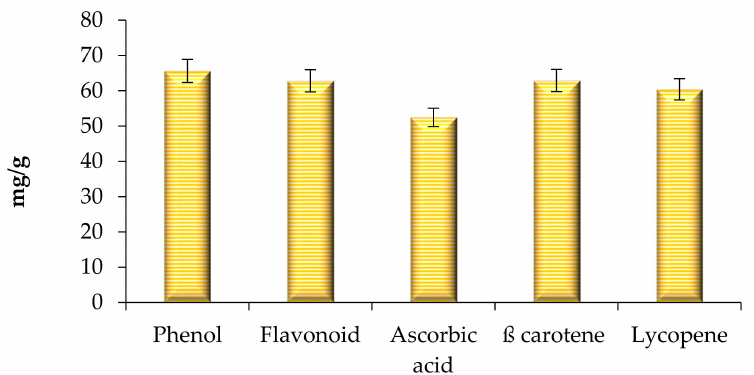
Figure 7. Total phenol, flavonoid, ascorbic acid content, total β -carotene, and lycopene content of modified solvent evaporated Woodfordia fruticosa flower extract. Data are presented as means ± SEM ( n = 3).